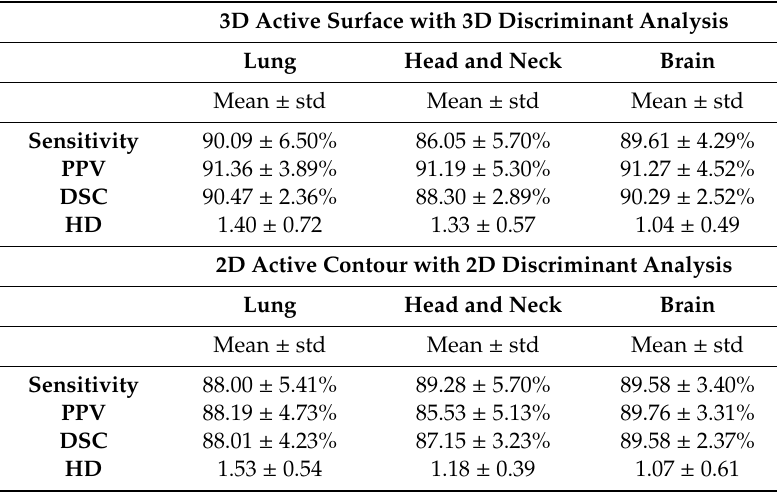
Table 1. Sensitivities, PPVs, DSCs and HDs for cancer studies using the 3D and 2D algorithms.